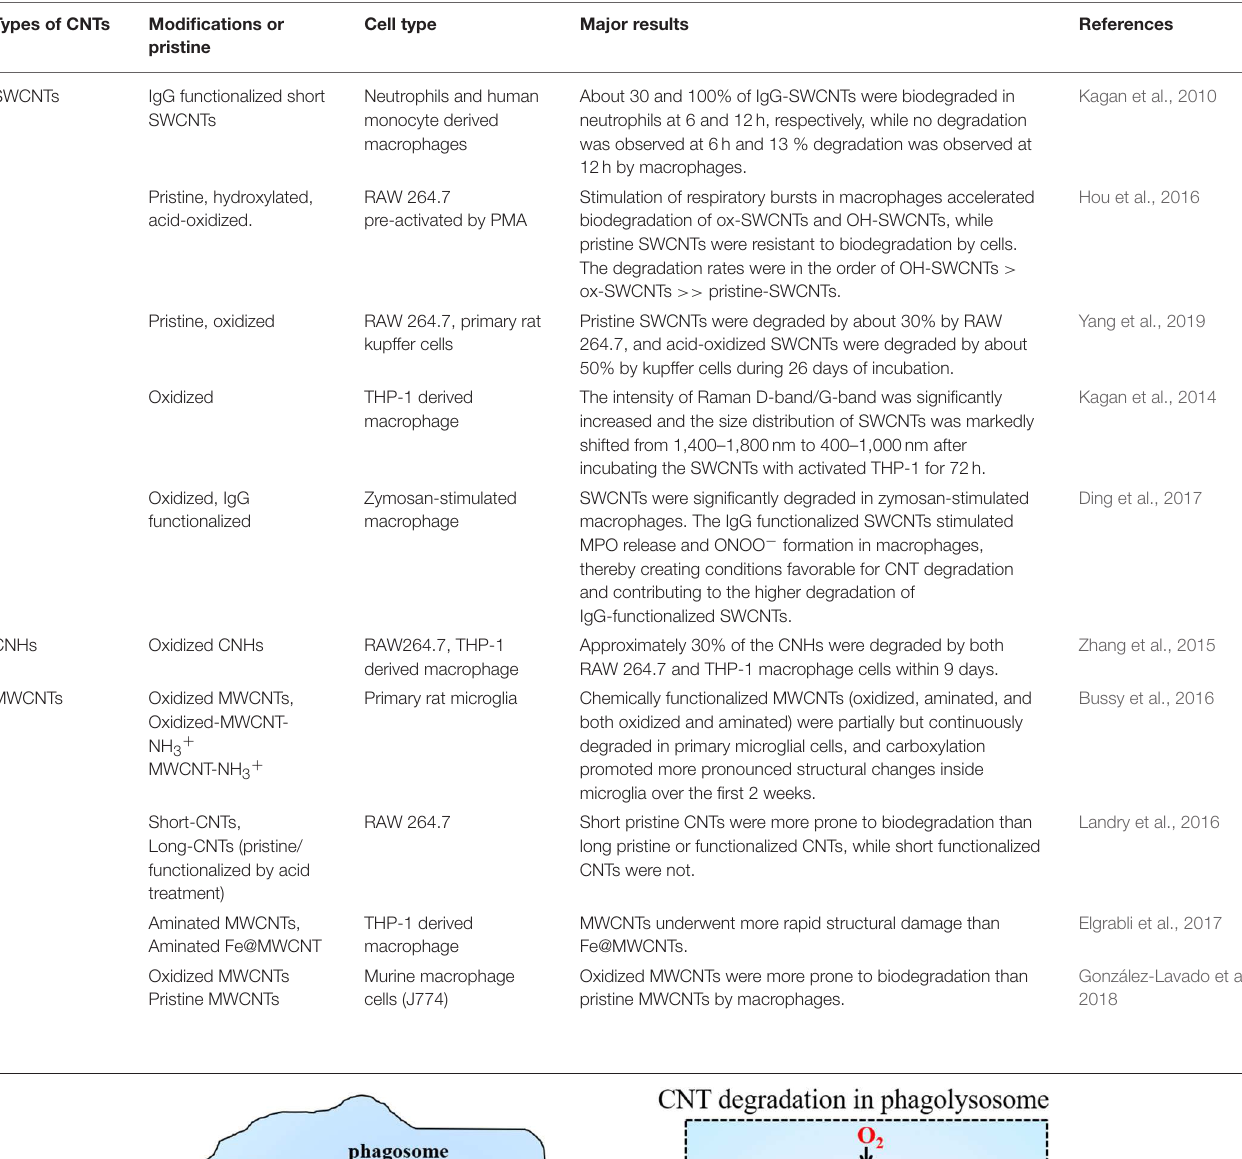
TABLE 1 | Summary of the outcomes of macrophage-based CNT degradation methods reported in the literature.